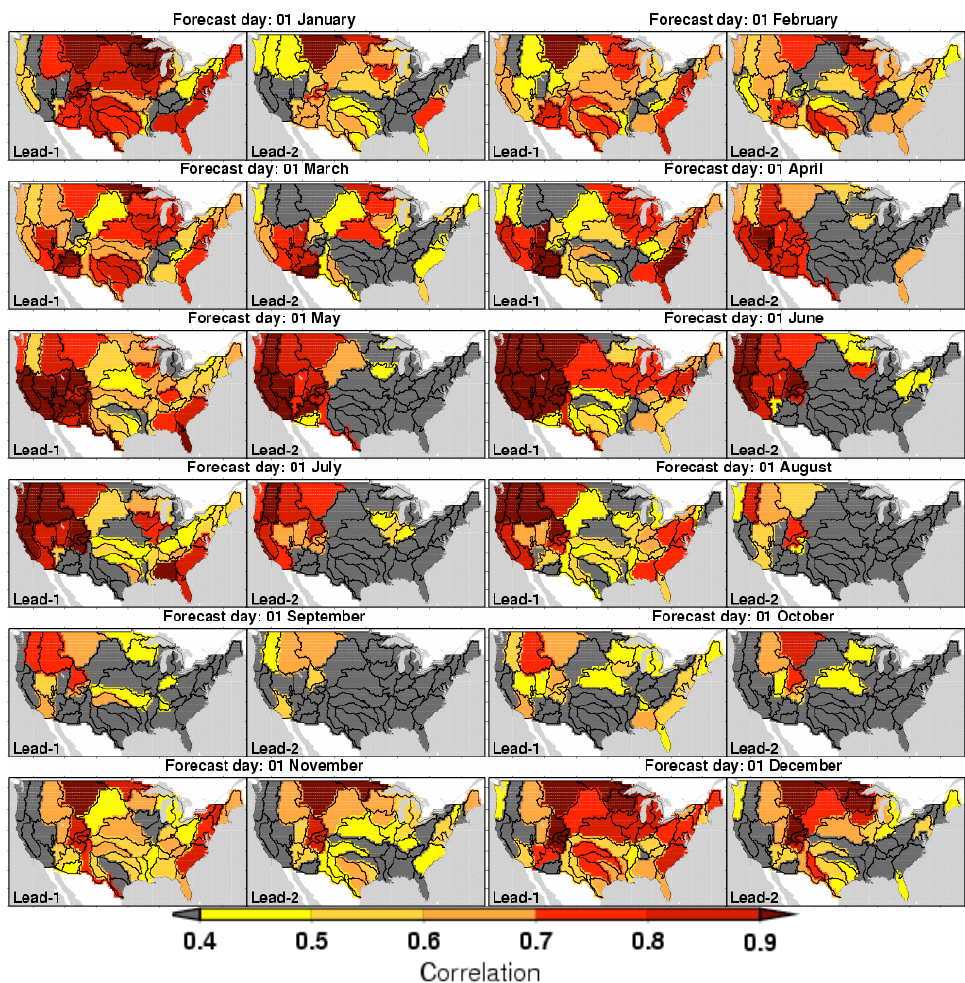
Fig. 4. Baseline skill (i.e. skill of ESP experiment) for runoff forecasts at leads 1–2 months (dark grey color shows the sub-regions where the Figure 4: Baseline skill (i.e., skill of ESP experiment) for runoff forecasts at leads 1-2 3 baseline skill is not significant at the 95% significance months. (Dark grey color shows the sub-regions where the baseline skill is not 4 significant at 95% significance level.) 5